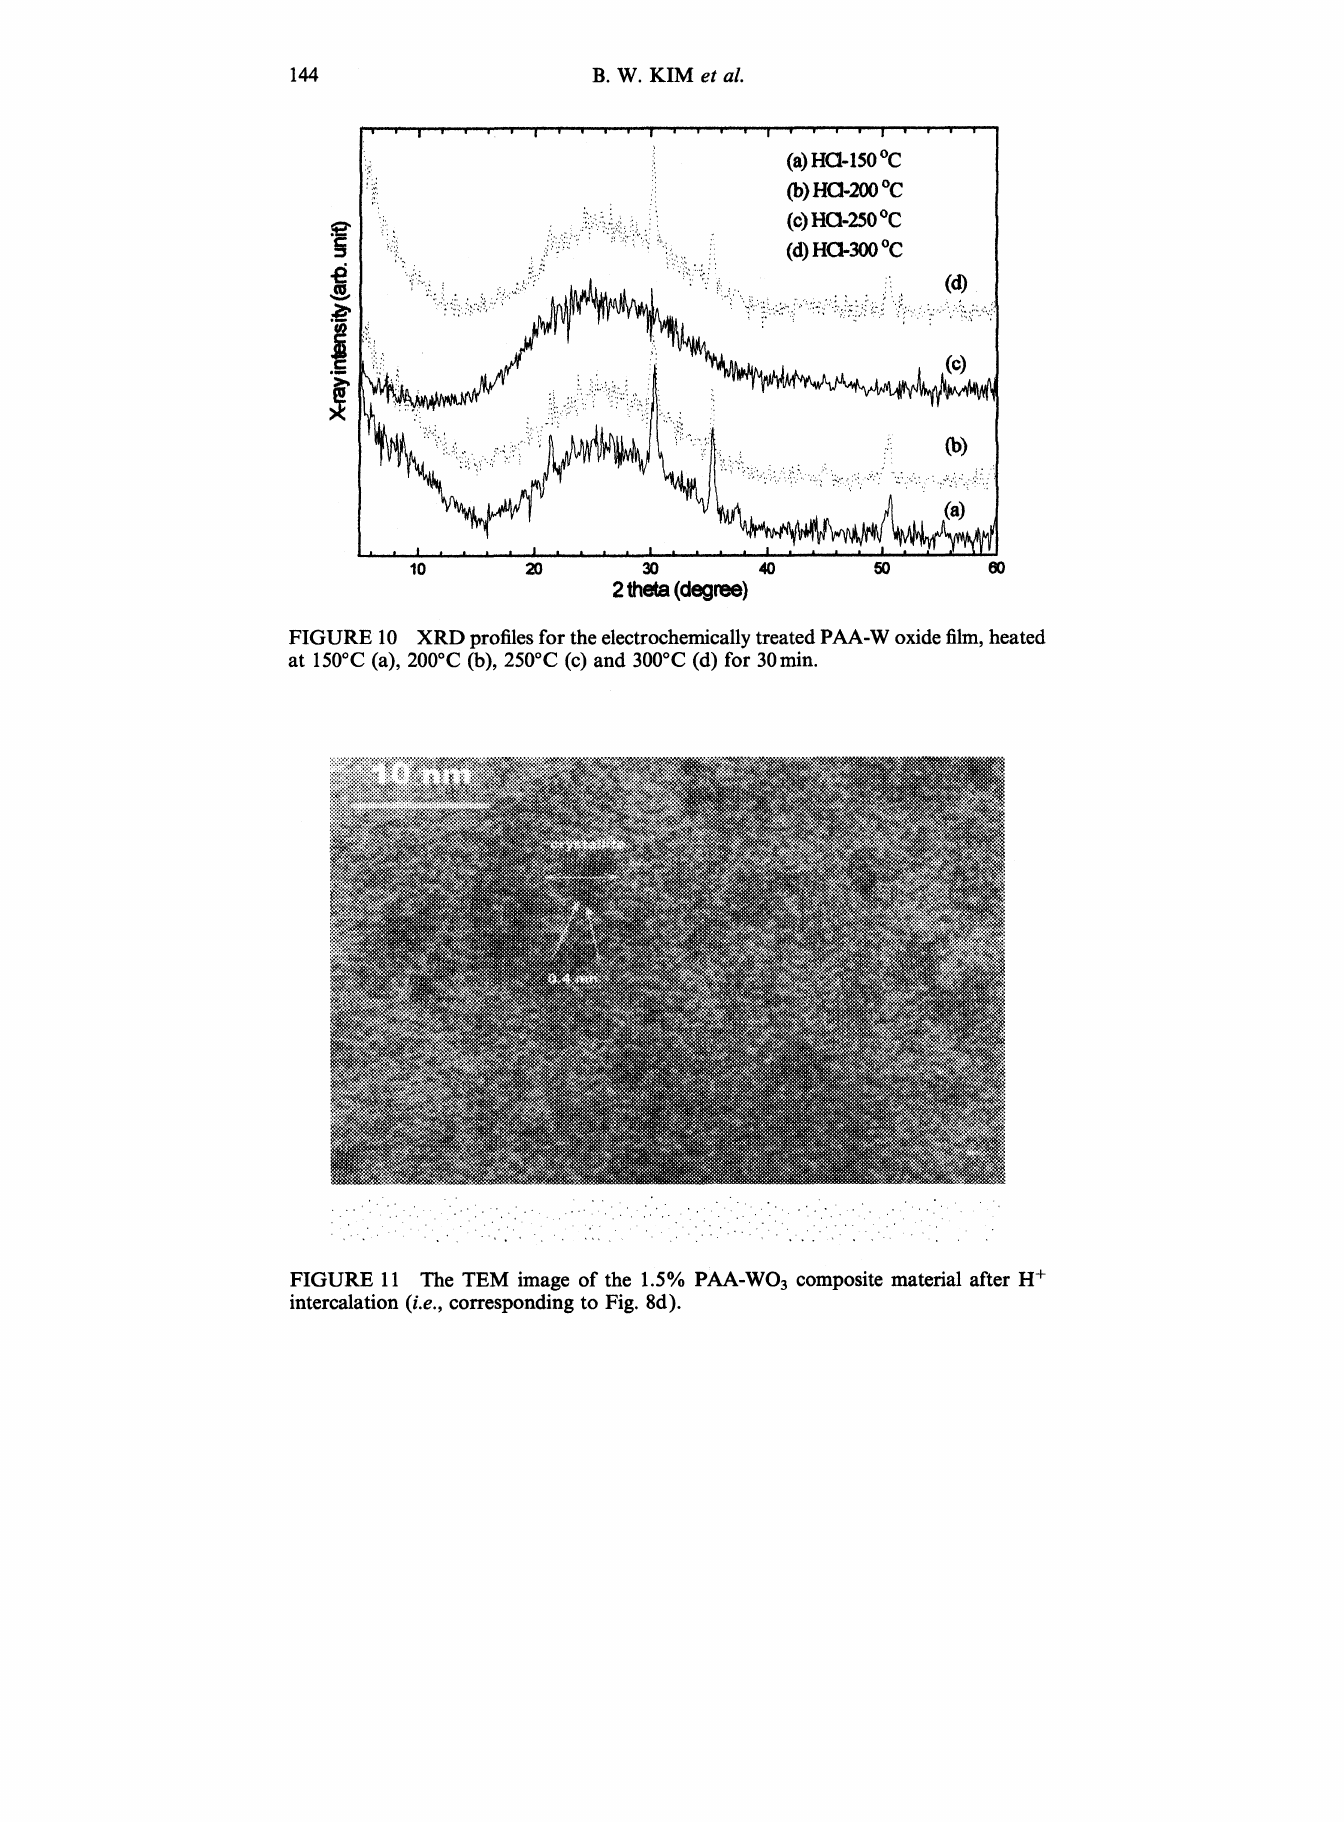
FIGURE 11 The TEM image of the 1.5% PAA-WO3 composite material after H + intercalation (i.e., corresponding to Fig.